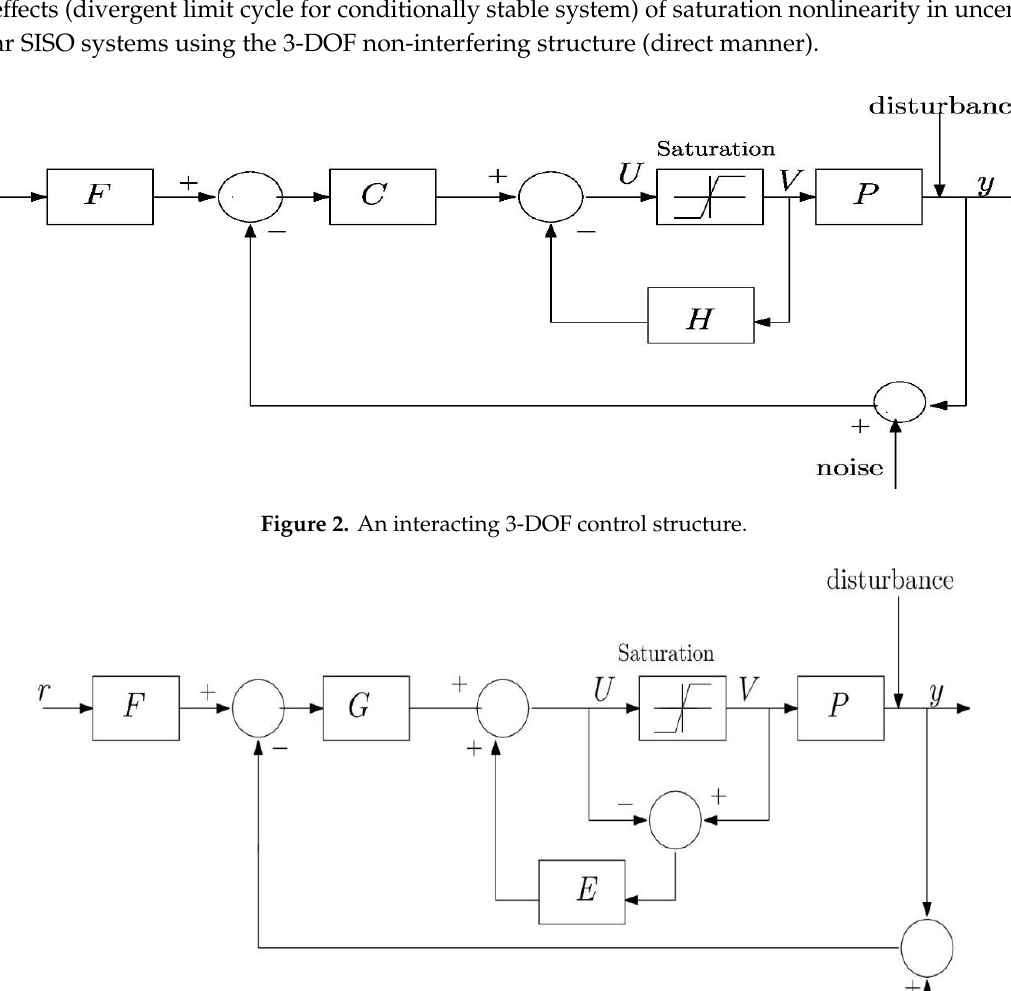
Figure 1. A two degree of freedom (2-DOF) structure with actuator saturation.